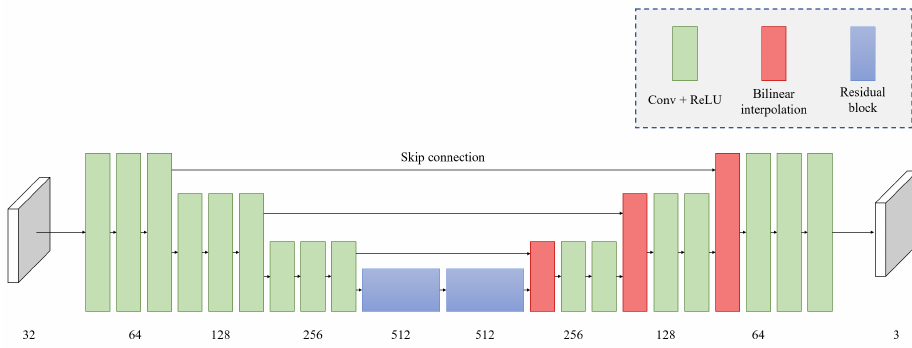
Figure 5. Structure of the refinement